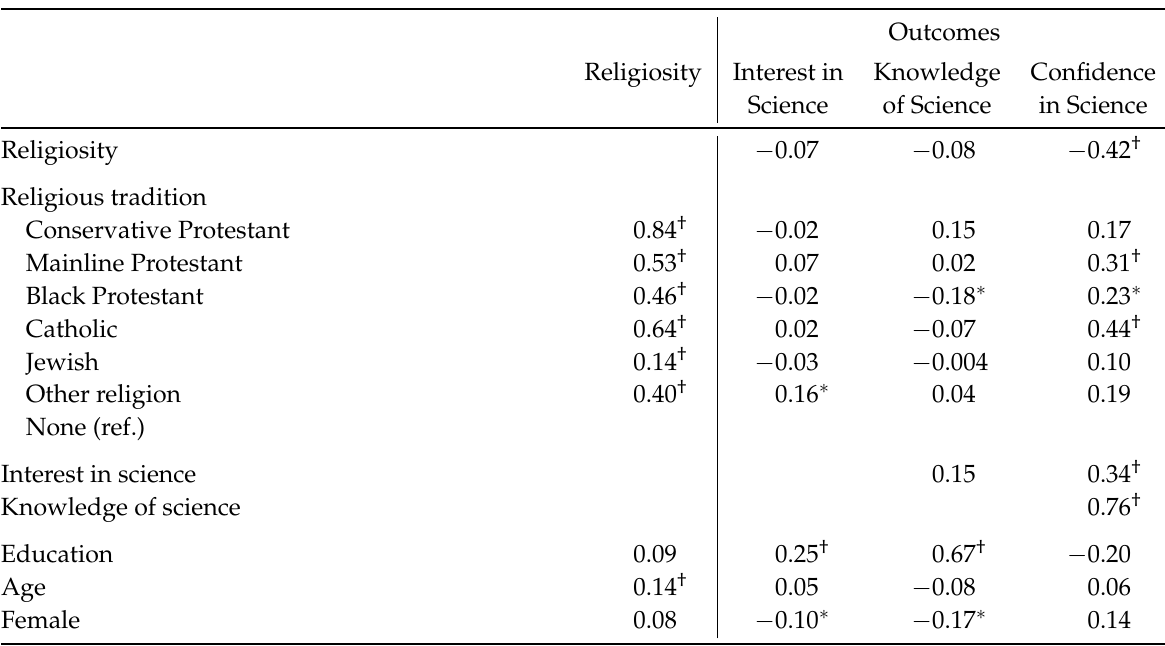
Table 2: Standardized Results from Structural Components of Analytical